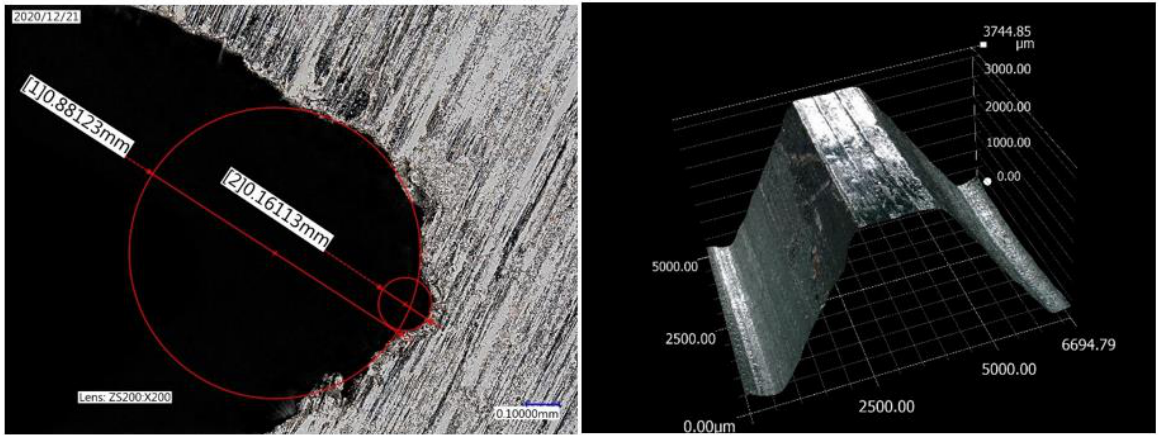
Figure 9. Exact values of thread geometry obtained using a Keyence VHX 6000 digital microscope.